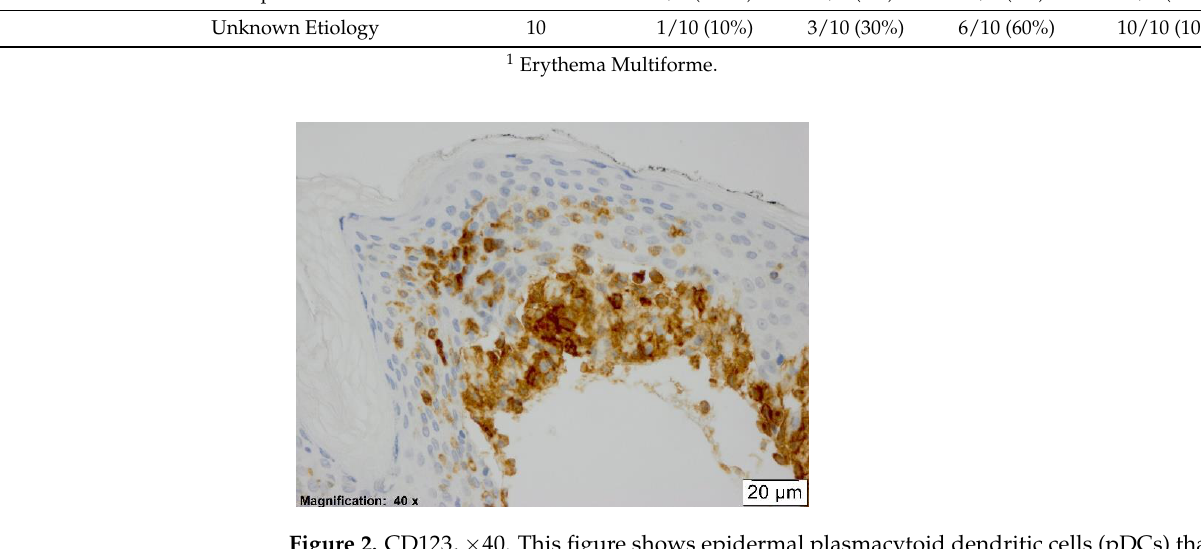
Figure 2. CD123, ×40. This figure shows epidermal plasmacytoid dendritic cells (pDCs) that have Figure 2. CD123, × 40. This figure shows epidermal plasmacytoid dendritic cells (pDCs) that have epithelioid and spindle shape. epithelioid and spindle shape. Overall, the number of pDCs observed correlated with the extensiveness of the der- higher density of pDCs (see Figure 3a,b)